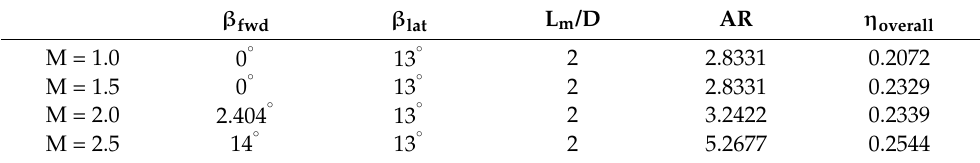
Table 3. Values for the optimized holes (DR = 2.0).